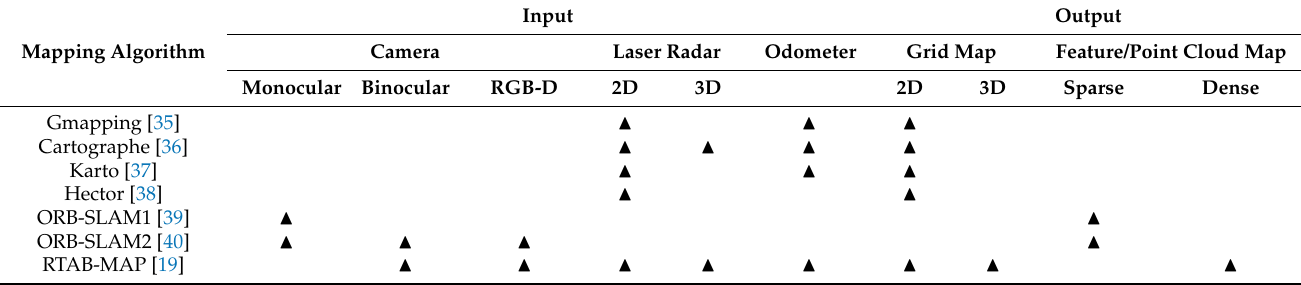
Table 1. Common mapping schemes of laser/visual SLAM